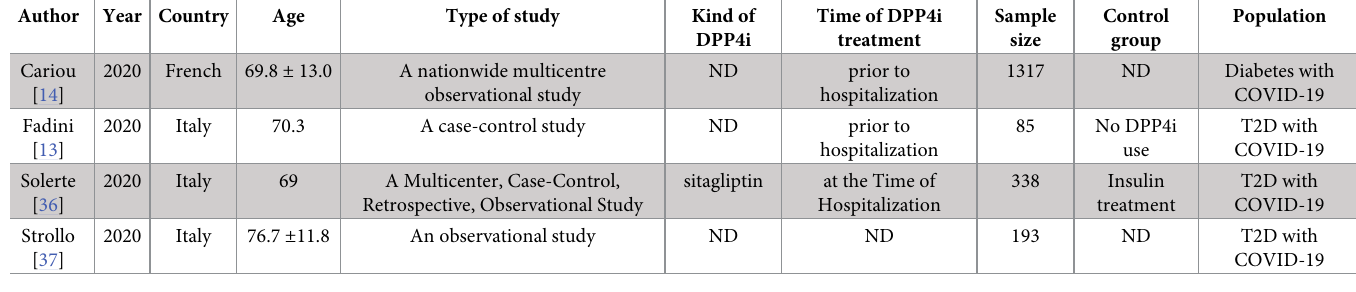
Table 1. Description of eligible studies reporting the association between DPP-4i and the mortality of